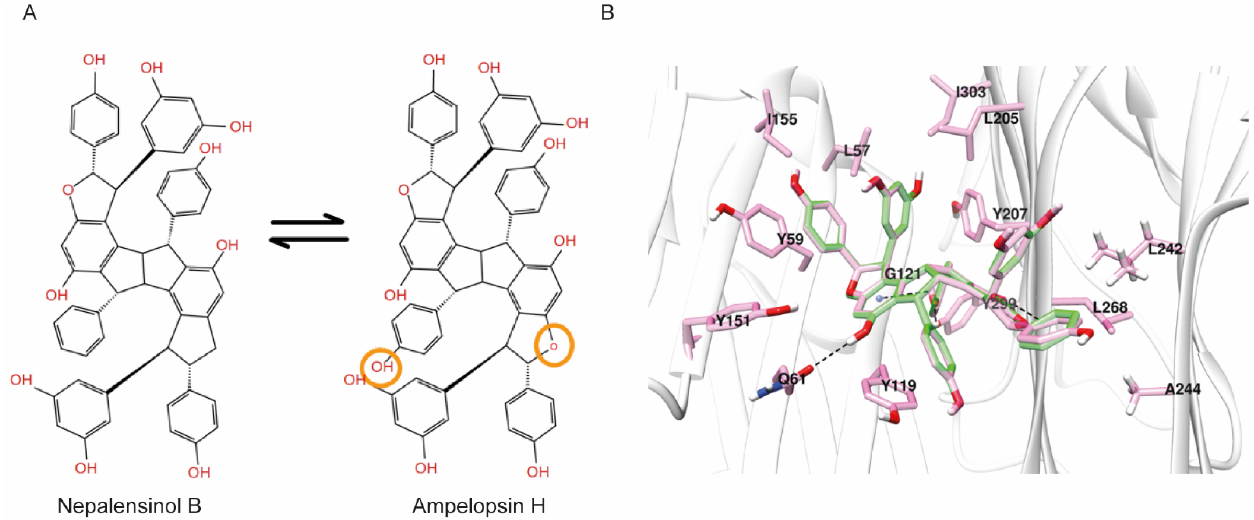
Figure 9. ( A ) The structures of Nepalensinol B and Ampelopsin H and their differences are highlighted with orange. ( B ) The binding of Ampelopsin after 1 μ s MD and its transformation into Nepalensinol (green) for the absolute binding energy calculation.